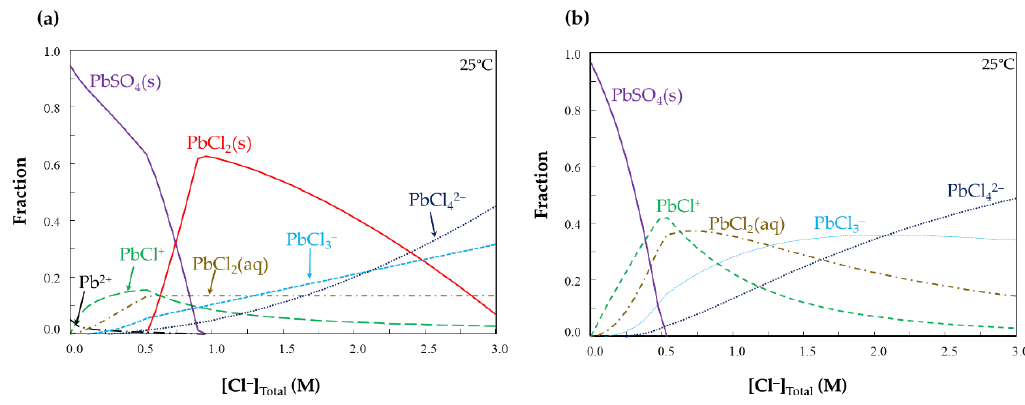
Figure 11. Effects of Pb 2+ concentration on solubility and speciation of Pb 2+ and Pb-Cl complexes in the lead-chloride-sulfate-water system under the condition ( a ) Pb 2+ = 8 mM, SO 42− = 8 mM, pH = 1, and ( b ) Pb 2+ = 1 mM, SO 42− = 8 mM, pH = 1 .